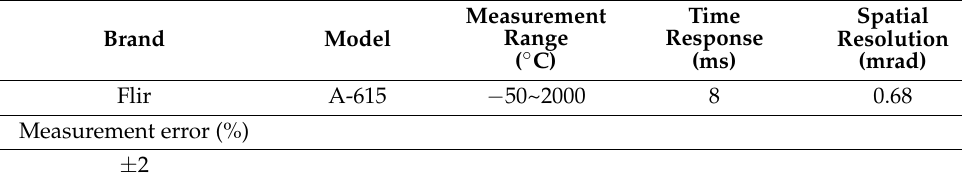
Table 3. Parameters of the infrared camera.